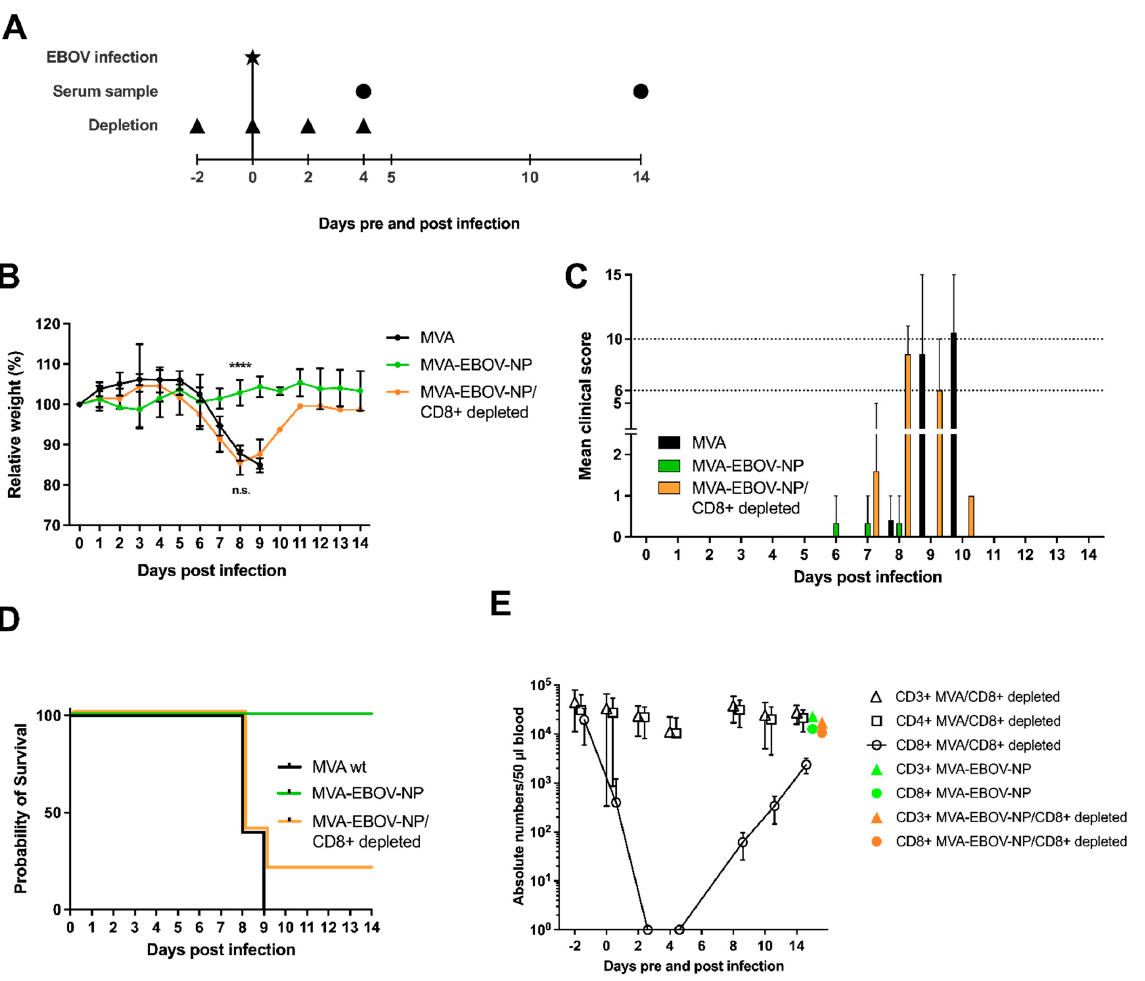
Figure 6. CD8+ T cells are required for protective MVA-EBOV-NP immunization. ( A ) IFNAR -/- mice were vaccinated as described above with either 10 8 PFU non-recombinant MVA (MVA) as control or with 10 8 PFU of the MVA-EBOV-NP; MVA, MVA-EBOV-NP/CD8+ depleted: n = 6 mice, MVA-EBOV-NP: n = 3 mice. Depletion of CD8+ T cell was carried out by intraperitoneal injection of an anti-CD8+ antibody at the indicated time points. MVA-and MVA-EBOV-NP-vaccinated mice, as well as MVA-EBOV-NP-vaccinated and depleted mice were challenged with EBOV at day 65 after primary immunization. Depleted MVA-vaccinated mice were used as controls. Serum samples were obtained at the indicated time points after infection. ( B ) Mean relative body weight changes post challenge; error bars: standard deviation; **** p < 0.0001. ( C ) Mean clinical score comprising body weight, general condition and spontaneous behavior. The clinical end point was defined as an individual score of 10 or of 6 on two consecutive days (dotted lines); error bars: maximum score. ( D ) Kaplan–Meier survival curves. I FACS analysis for CD3+, CD4+ and CD8+ T cells. Numbers of the respective T cell population of MVA-vaccinated (CD8+ depleted) mice ( n = 4) compared to one MVA-EBOV-NP-vaccinated (not CD8+ depleted) mouse and one surviving MVA-EBOV-NP- vaccinated (CD8+ depleted) mouse (data summarized in one graph for better visualization). 14